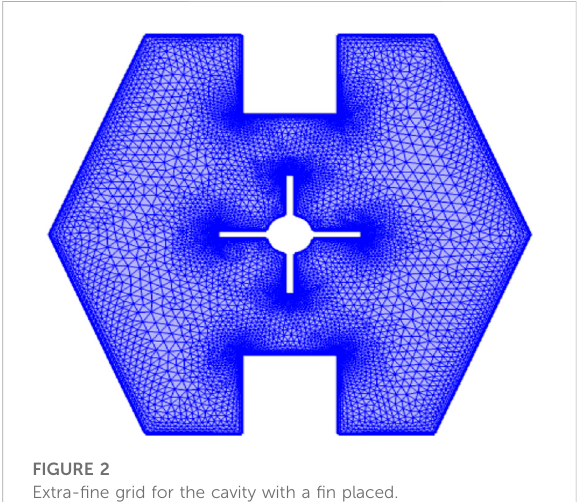
FIGURE 2 Extra- fi ne grid for the cavity with a fi n